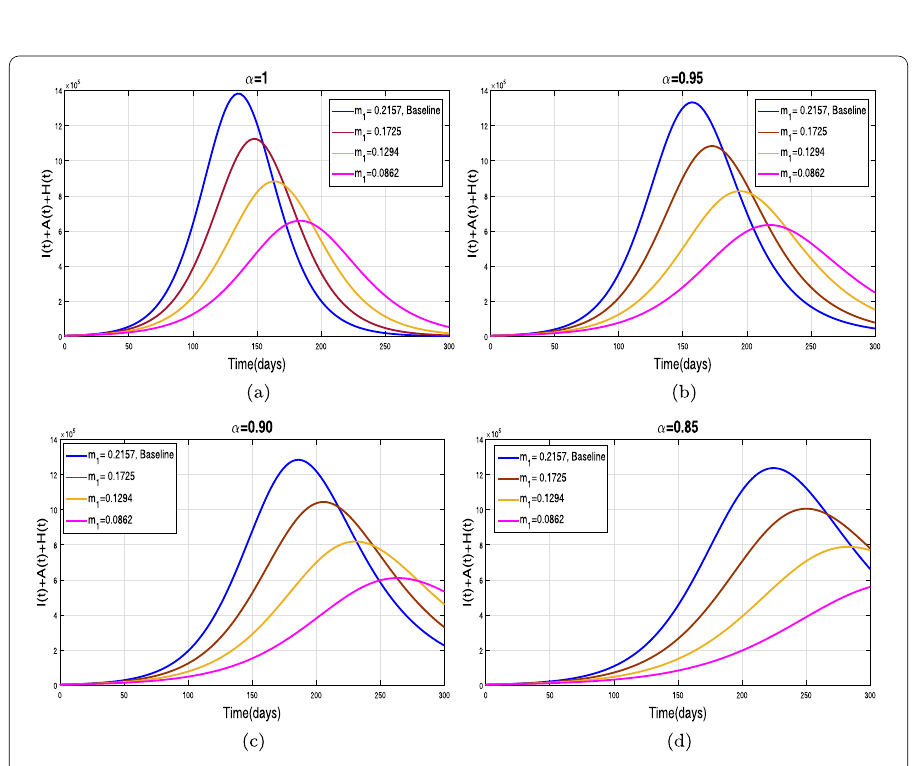
Figure 7 The impact of viral influence of A individuals to the environment on I , A , and H individuals for α = 1, α = 0.95, α = 0.90, α =